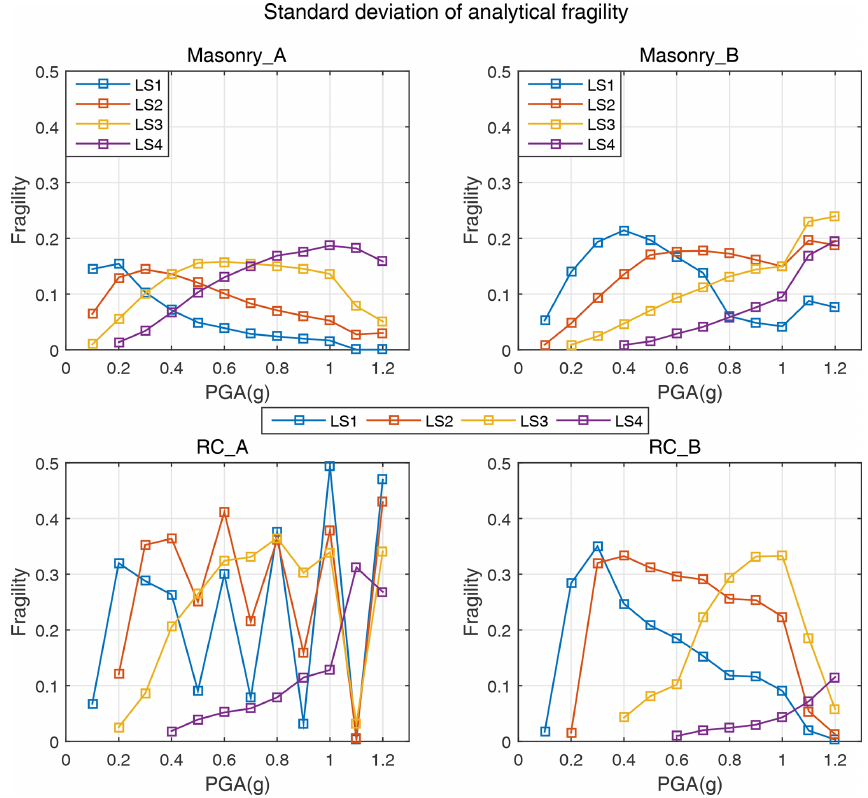
Figure A4. Standard deviation of analytical fragility, namely the exceedance probability of each damage limit state (LS1, LS2, LS3, LS4) derived based on analytical fragility datasets for each building type (Masonry_A, Masonry_B, RC_A, RC_B; detailed values are given in Table B1). Only intensity and PGA values with truncated exceedance probability ≥ 1% for each damage limit state of each building type are plotted, since higher damage states can appear only for higher intensities or PGA values (see Sect. 5.2 for more